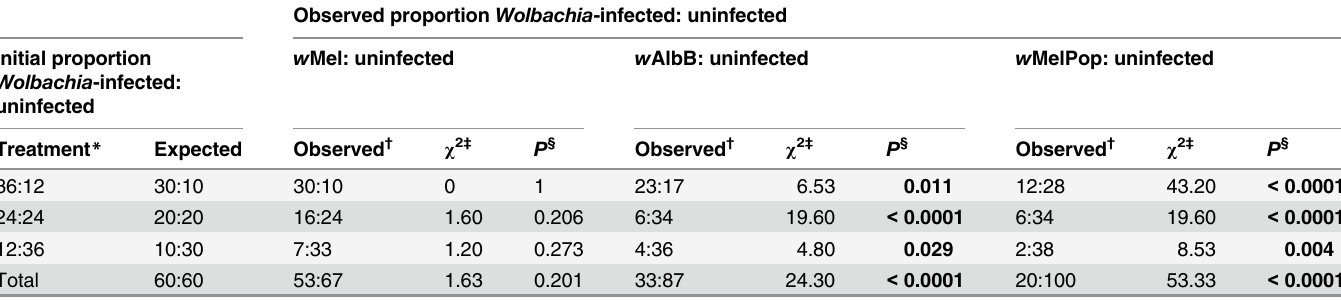
* Within a column, values with the same letter in bold are not signi fi cantly different from each other ( P > 0.05, by Tukey ’ s honest signi fi cant difference test) † Within a column, values with the same letter in bold are not signi fi cantly different from each other ( P > 0.05, by Mann-Whitney U tests on data pooled across replicates)